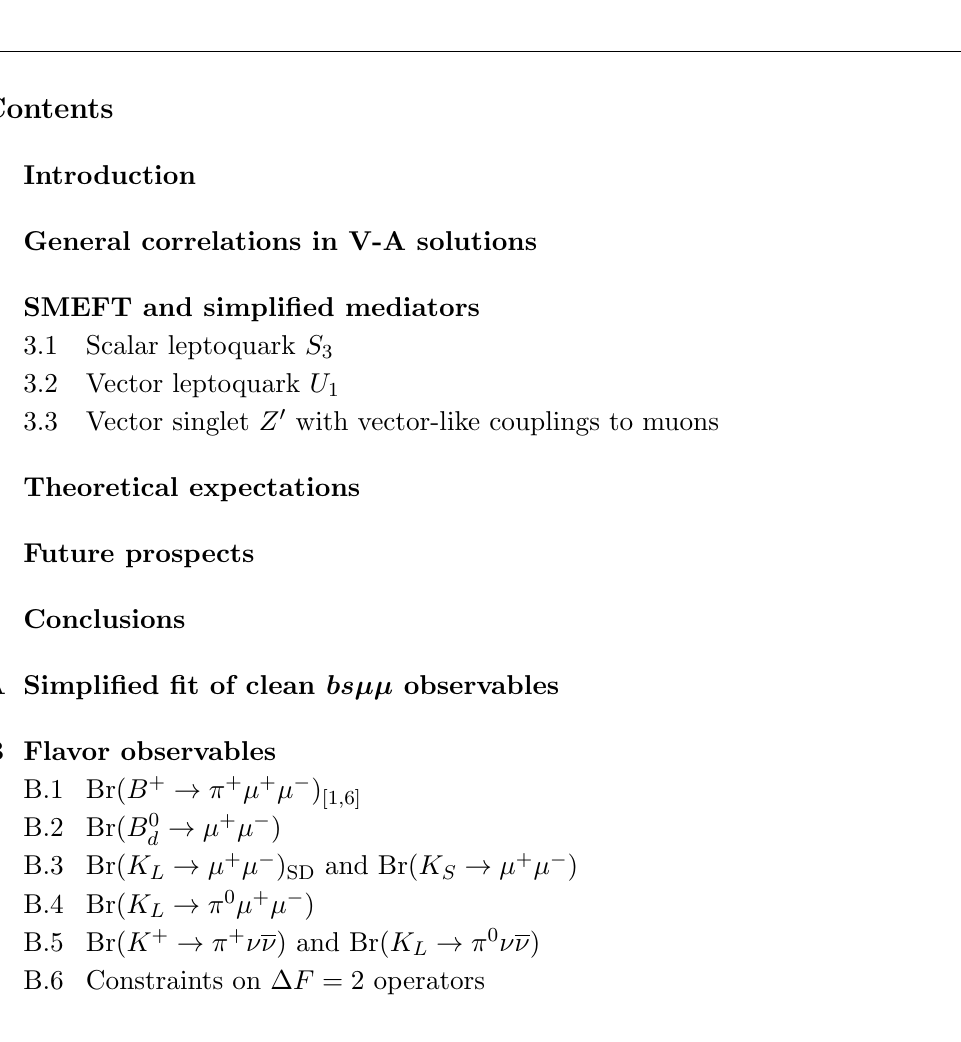
Model-independent analyses of neutral-current anomalies hint towards NP coupling to quark and lepton vectorial currents [11{25]. As a matter of fact, the vast majority of NP